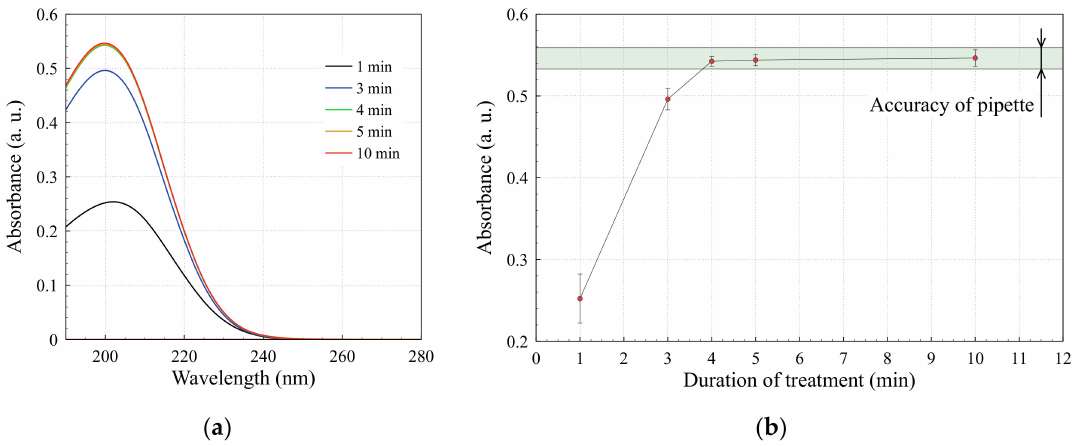
Figure 4. ( a ) DUV absorption spectra and ( b ) intensity of absorption peak at 200 nm of flowing DI water treated with AAGD, sampled at 1, 3, 4, 5, and 10 m after treatment